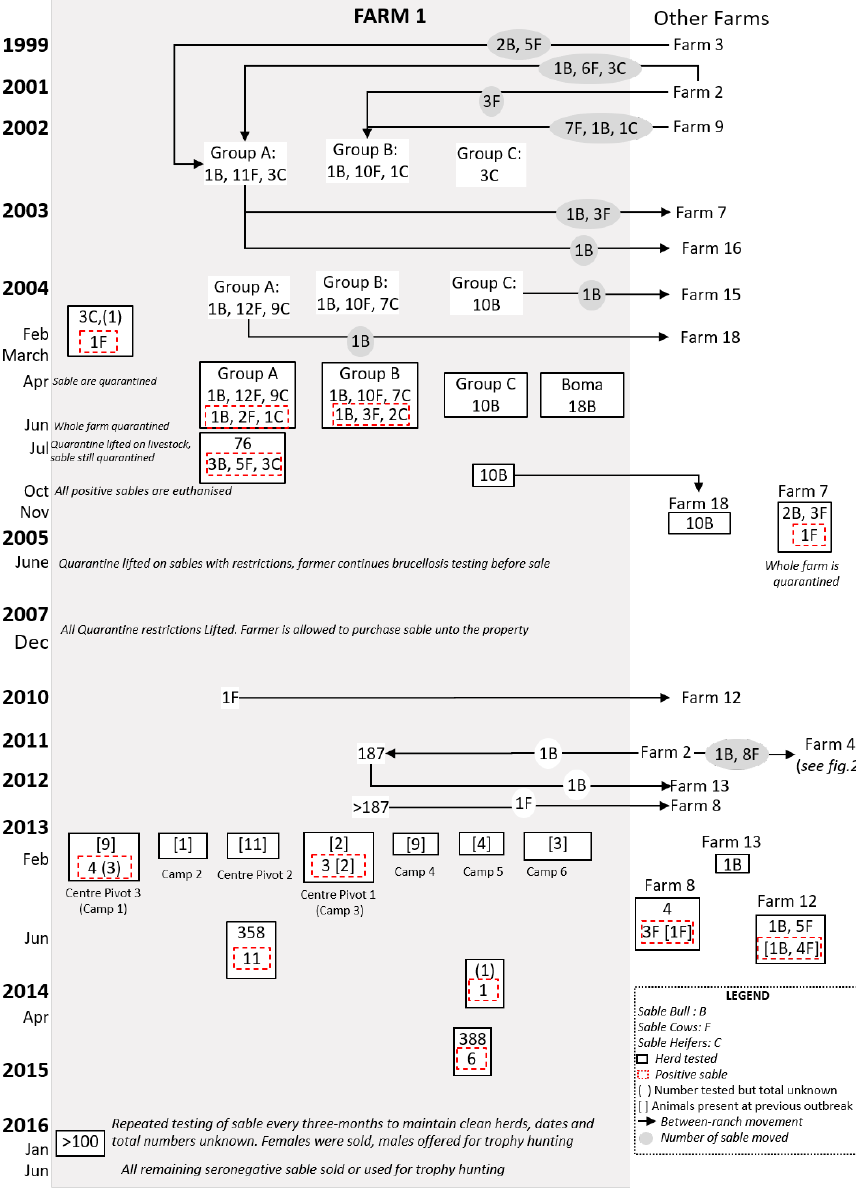
Figure 1. Flow diagram of postulated brucellosis spread in Farm 1 from 1999 to 2016. Seropositive and seronegative herds are indicated at the time of testing. The sable (bull (B), cow (F), or heifers (C) on Farm 1 with movements (indicated by the grey circle) and groups are shown from 1999 to 2003 before the first brucellosis-seropositive animals were tested in 2004 (indicated by stipulated red